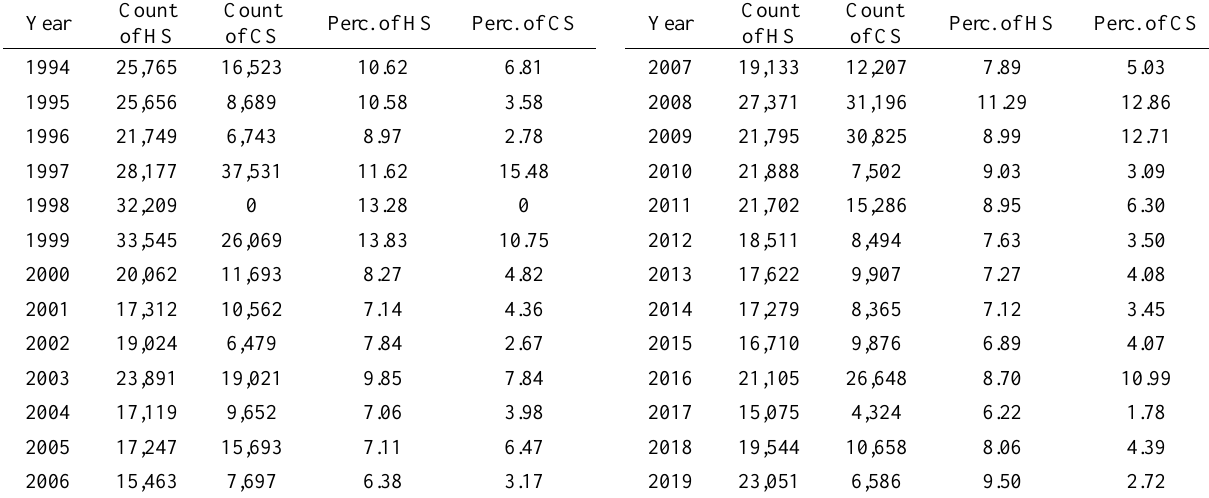
Table 2. Annual count and percentage of grids of HS and CS.